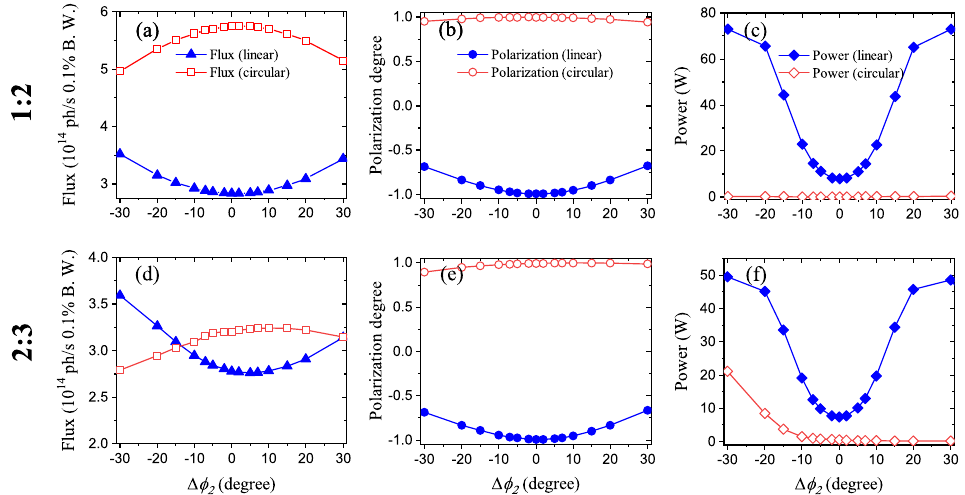
FIG. 12. The flux (left), polarization degree (middle) and power (right) depend on the deviation of phase shift ϕ 2 . Upper subfigures are corresponding to the Fig. 8 AMPU and lower subfigures are corresponding to the Knot AMPU, respectively.